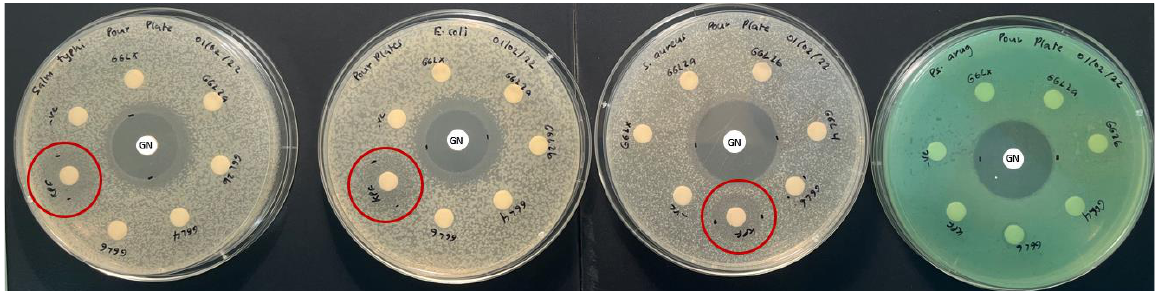
Figure 5. Kakadu plum flesh antibacterial